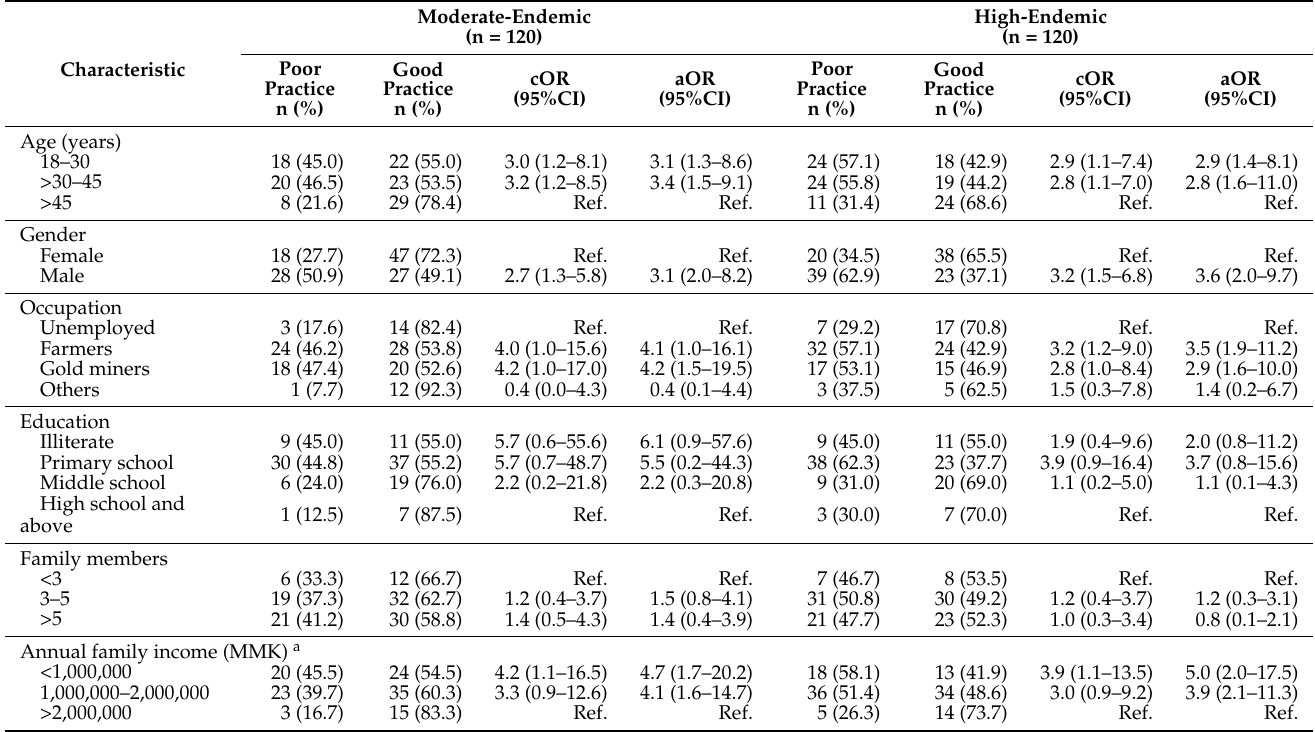
Table 4. Factors associated with poor malaria preventive practices among people residing in moderate- and high-malaria-endemic